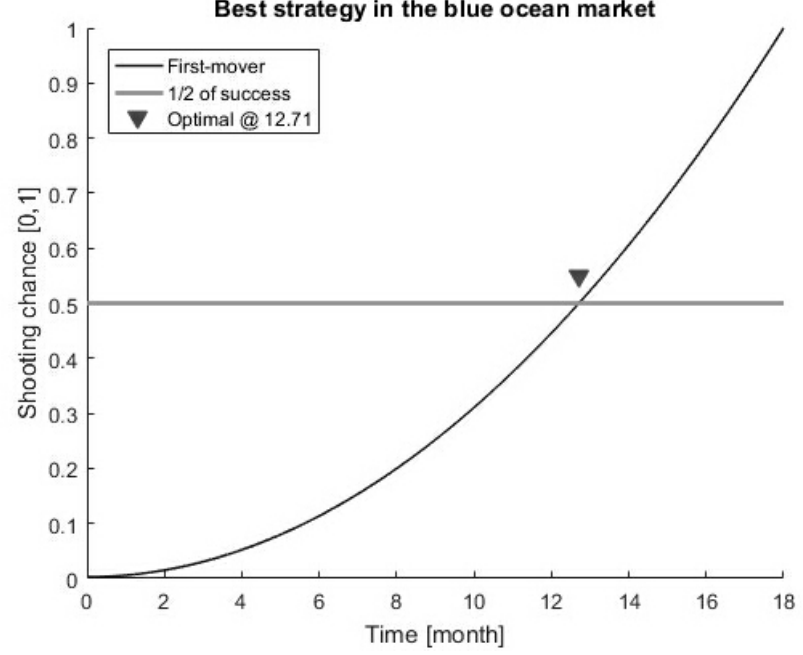
Figure 3. Best strategy for a first-mover in the pure blue ocean